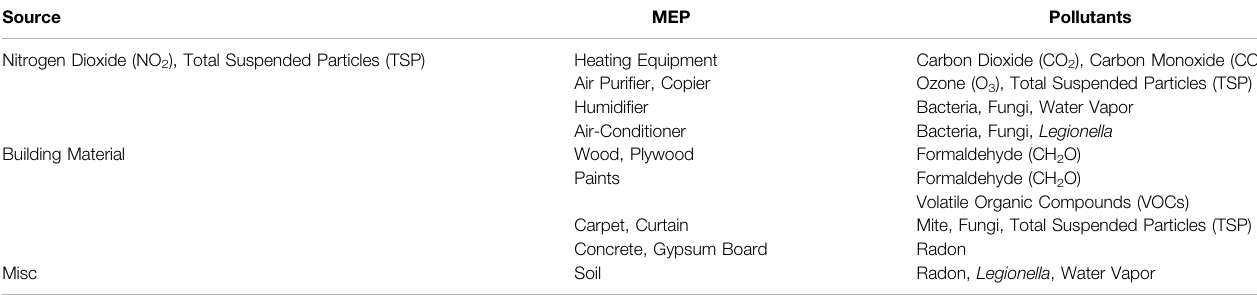
TABLE 1 | Hazardous substances source and pollutants (source: Jung, 2021).